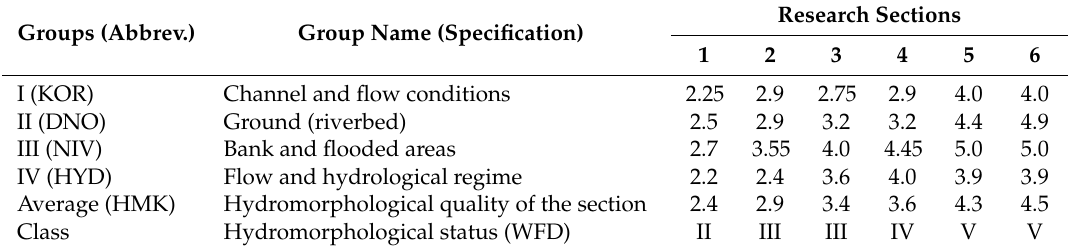
Table 11. Results of the hydromorphological status testing in the research sections under analysis based on the HEM method (Stage II—indicators calculated for groups and sections, classification to status